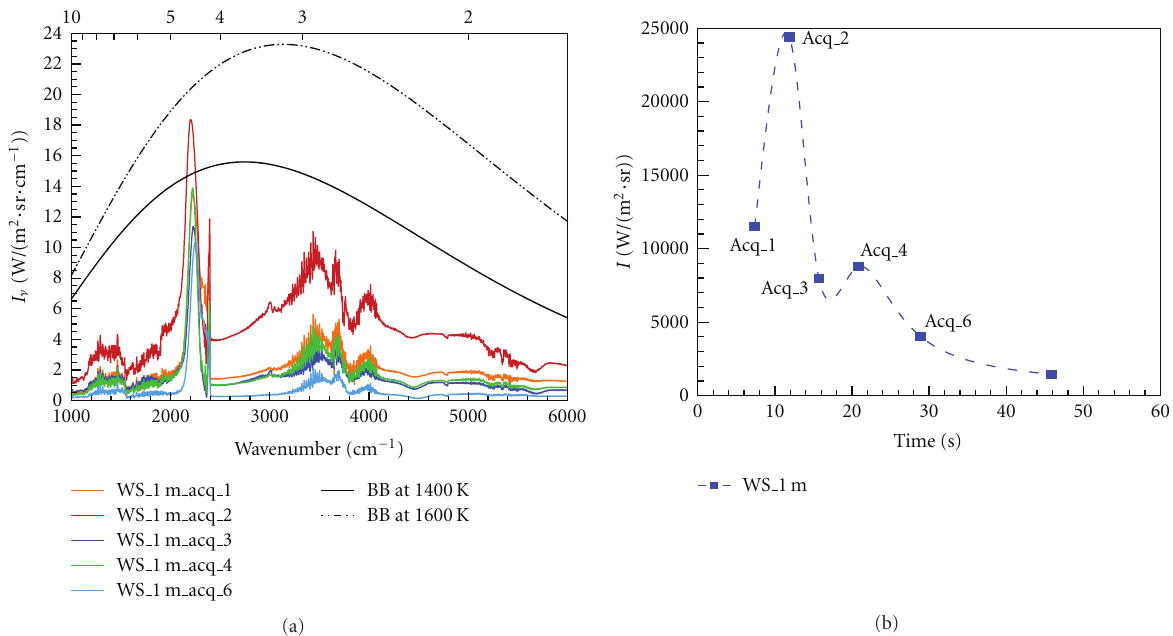
Figure 2: Emitted radiation from flames generated by the burning of the 1 m long WS fuel bed. (a) Spectral intensity versus wavenumber (and wavelength) obtained from successive acquisitions and (b) intensity integrated over wavenumber versus time. Solid and dotted black lines correspond to blackbody emission curves at temperatures of 1400K and 1600K. The fuel load is 1kg/m 2 .